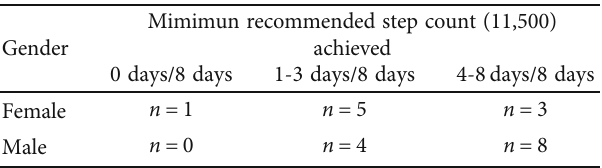
Table 3: Number of days during the 8-day wear protocol when the minimum recommended step count was